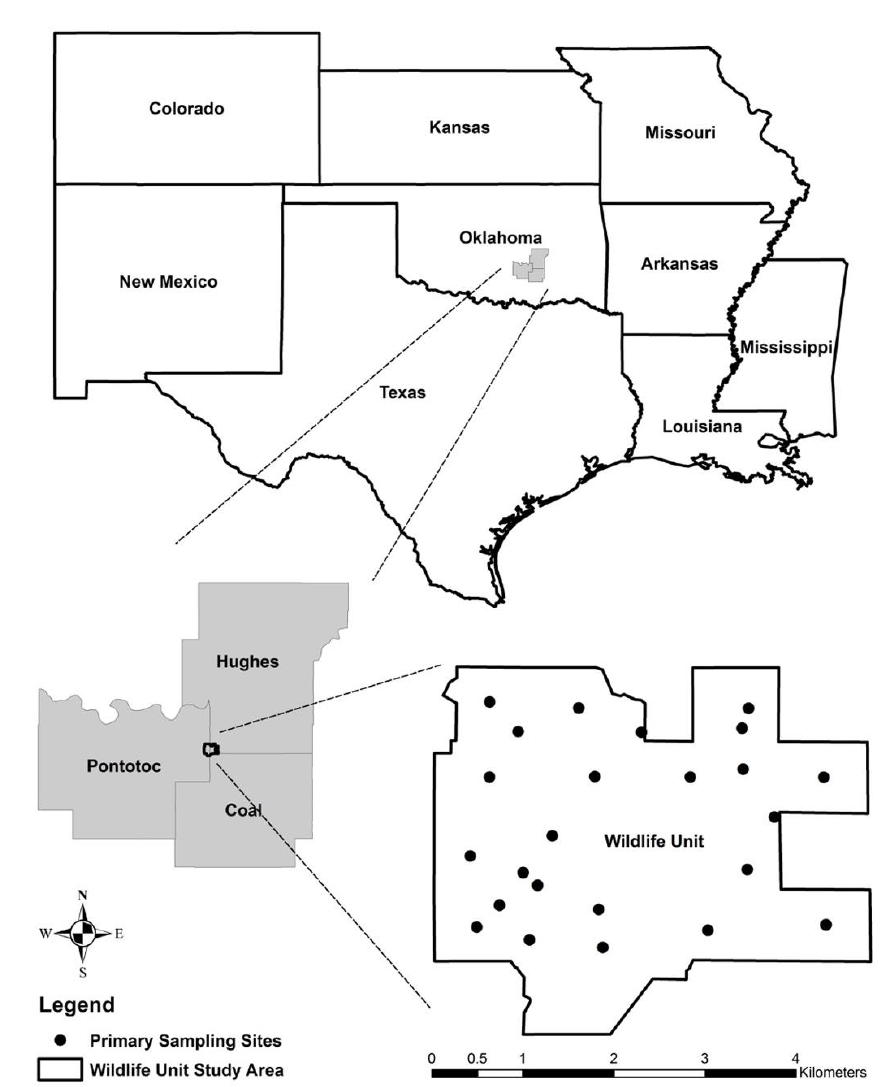
Figure 1. Sampling map of white-tailed deer confined population in Oklahoma. Sampling locations within the study area are designated; each symbol can represent multiple individuals sampled at that location.